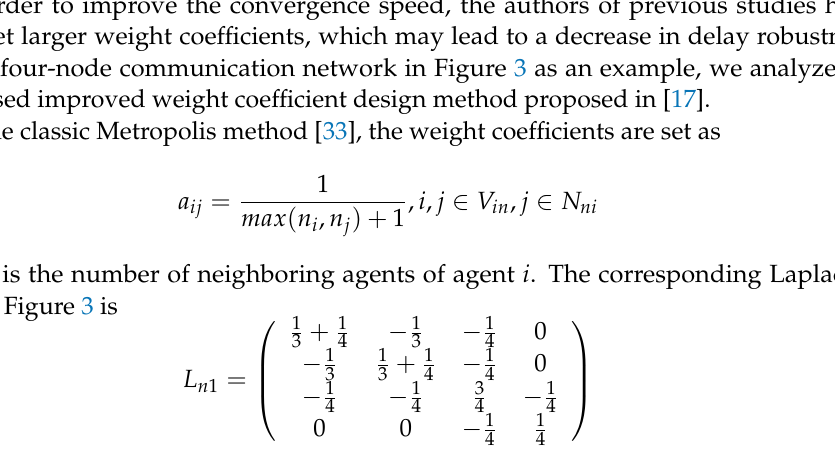
Figure 3. A four-node communication